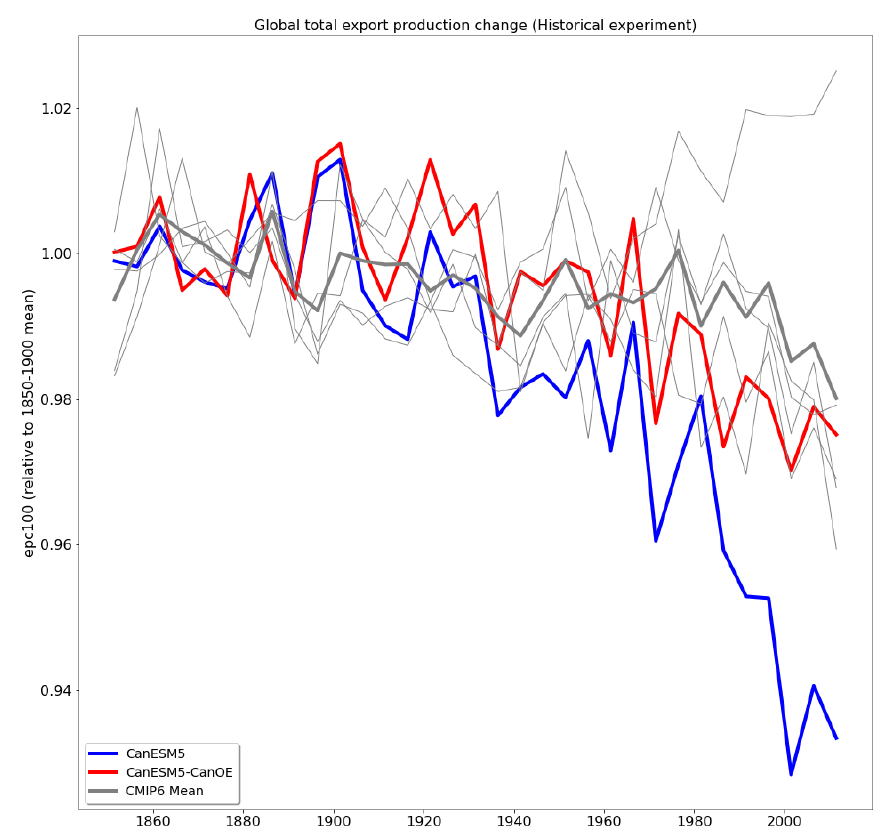
Figure 21. Change in export production (epc100) over the course of the historical experiment (1850–2014), normalized to the 1850–1900 mean. Data are shown as successive 5-year means. The thick red line represents CanESM5-CanOE, thick blue line CanESM5, thin grey lines other CMIP6 models, and thick grey line the ensemble mean of non-CanESM